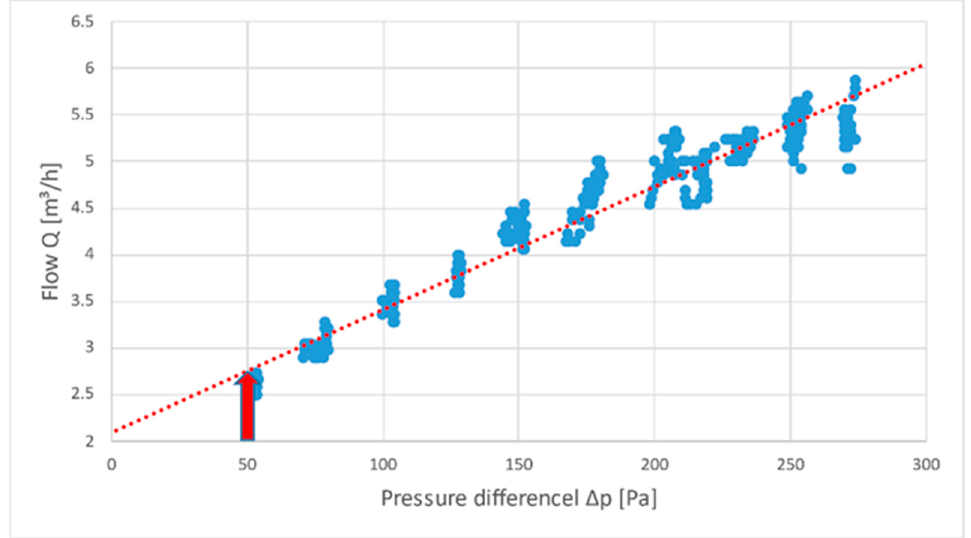
Figure 15. Variant 2 with additional tape to connect the top and bottom foil: ( a ) re-taping in the corner; ( b ) thorough sealing of the fragment.